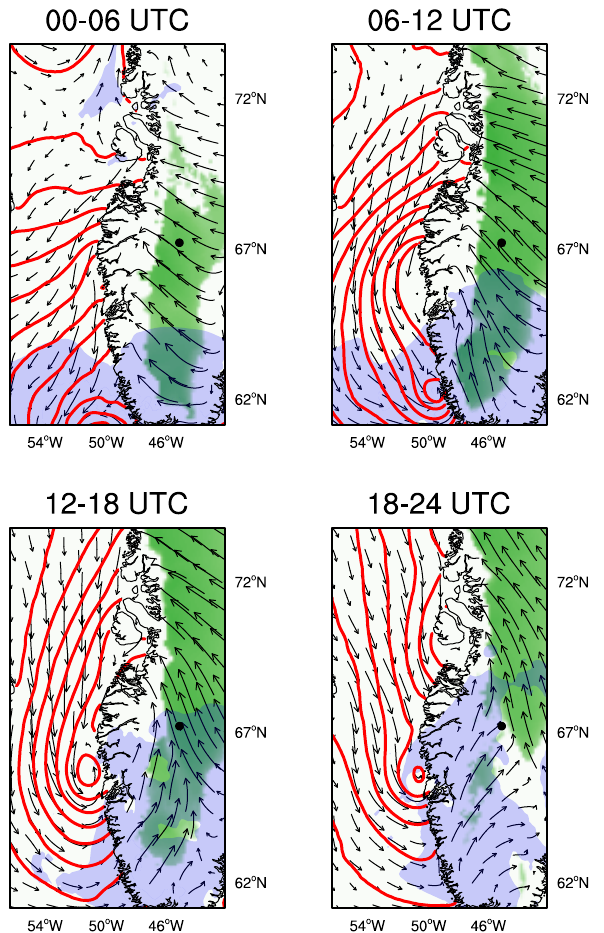
Fig. 11. Time evolution of the large-scale weather situation on 26 September 2012, with sea-level pressure (red lines), 10m wind (black arrows), precipitation (shaded blue if > 1mm w.e. per 6h) and vertically integrated drifting snow transport (shaded green if > 6000kgm − 1 per 6h). The location of S10 is indicated by the black dot in each panel.